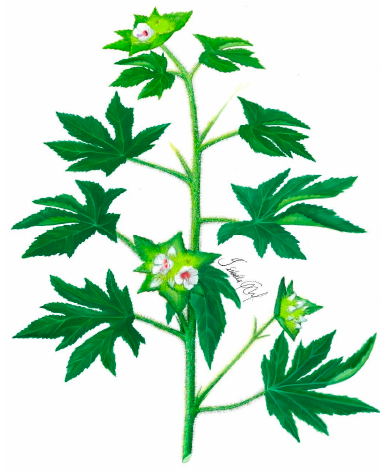
Figure 4. Malachra radiata (L.)